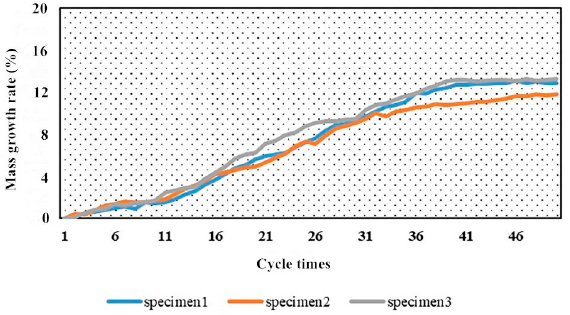
Figure 10. Variation of test piece quality growth rate with number of